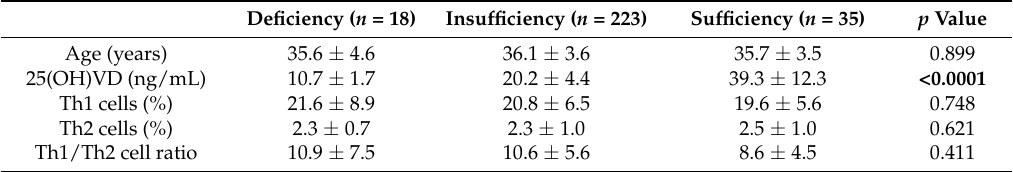
Table 1. Relationship between 25(OH)VD and T-helper (Th) cell populations in infertile